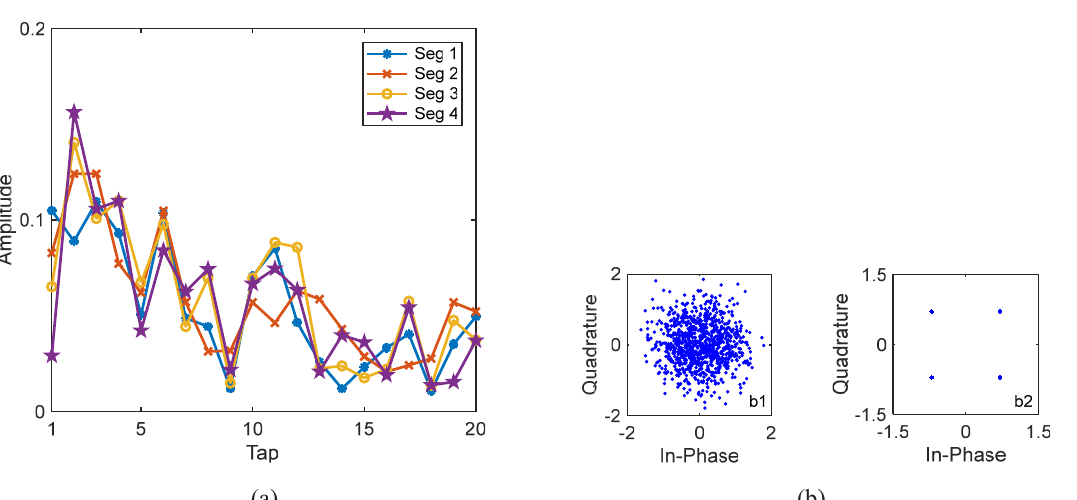
Figure 15. Estimated channels and equalization results of the first block with S256 and 1/16 code rate for Yellow Sea 1 in Figure 14. ( a ) The estimated channels of the consecutive four segments after 1 iteration; ( b1 ) constellations after 0 iteration; ( b2 ) constellations after 1